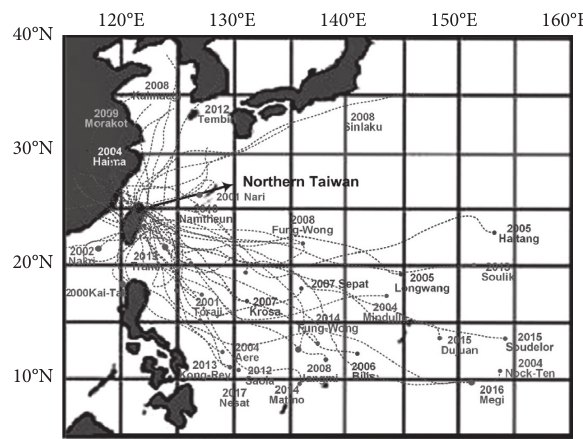
Figure 4: Tracks of historical typhoon incidents that affected